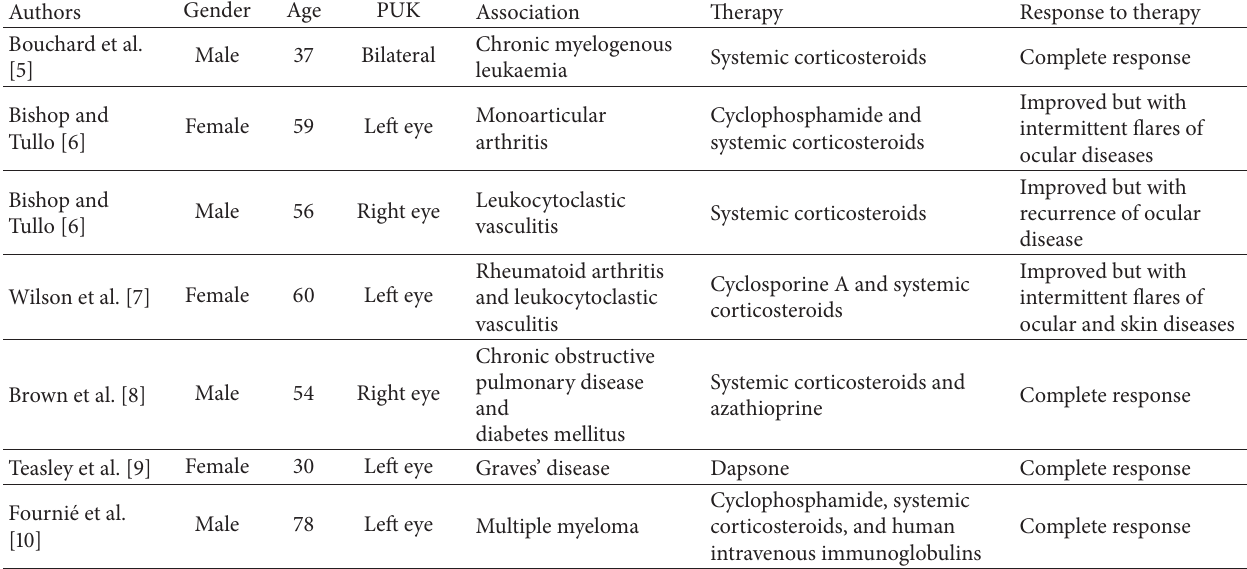
Table 1: Description of cases reported of pyoderma gangrenosum with peripheral ulcerative keratitis (PUK). Literature review.